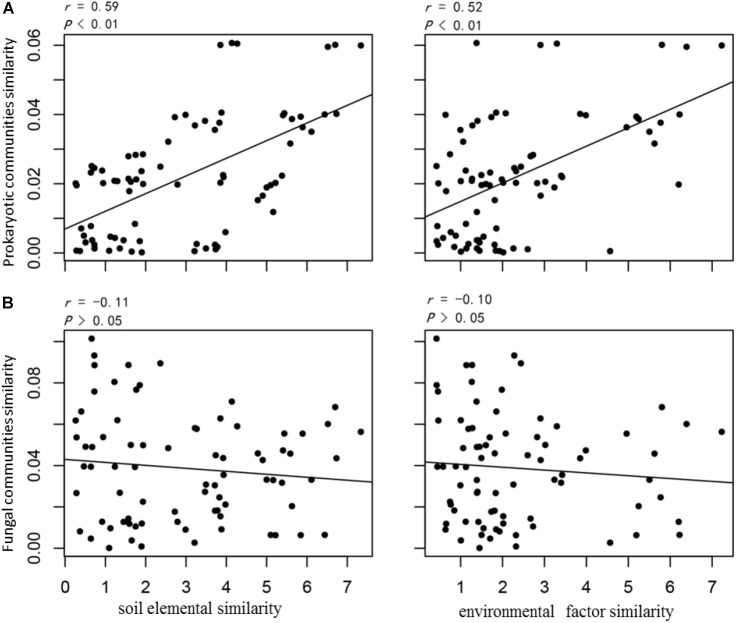
Pearson correlations between (A) the prokaryotic community and (B) the fungal community with soil elemental compositions and environmental attributes. Similarity values are directly indicated by calculated pairwise Euclid distances between samples.